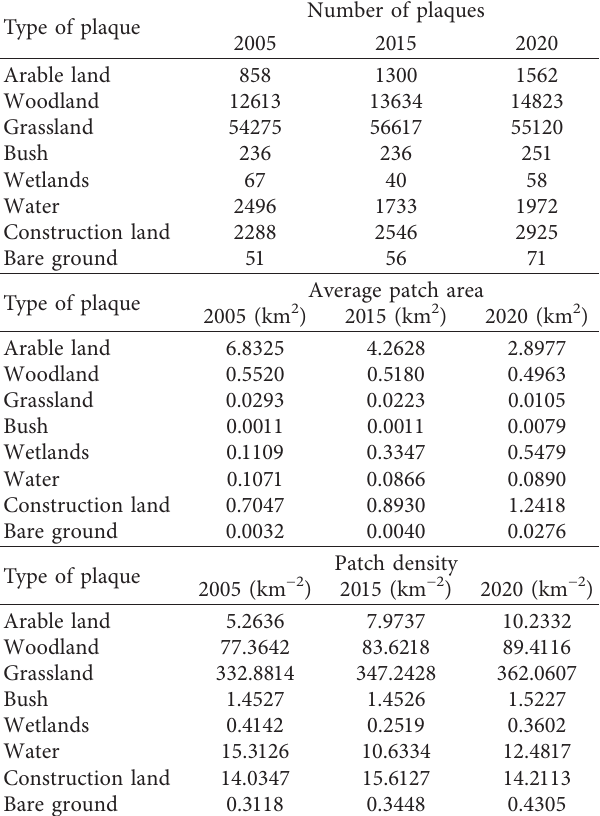
Table 5: Fragmentation index.